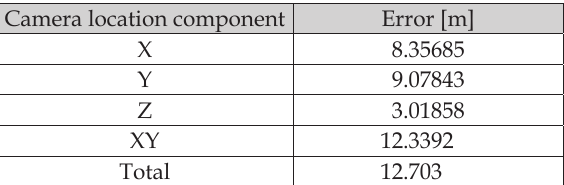
Table 3. Average camera location error.